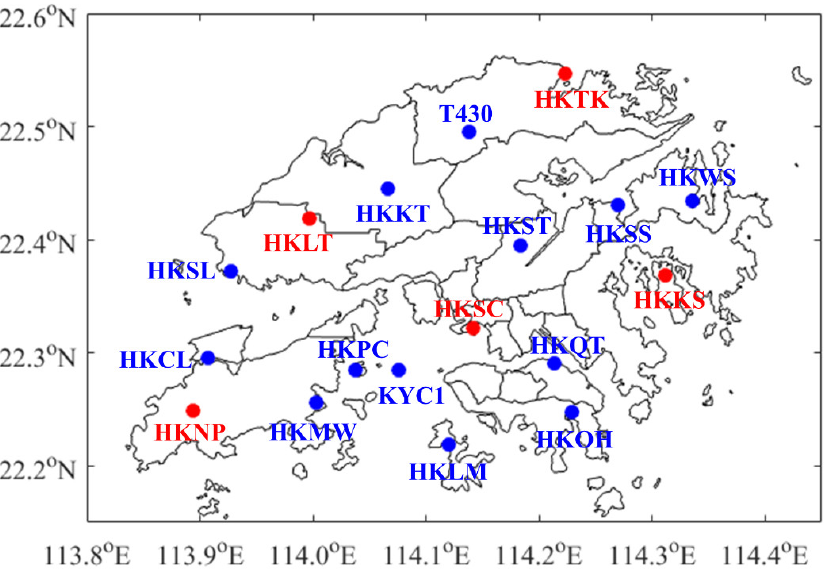
Figure 2. The distribution of the global navigation satellite system (GNSS) stations in Hong Kong (blue dots denote training sites and red dots represent test sites in ANN). Table 1. The coordinates of GNSS stations in Hong Kong.